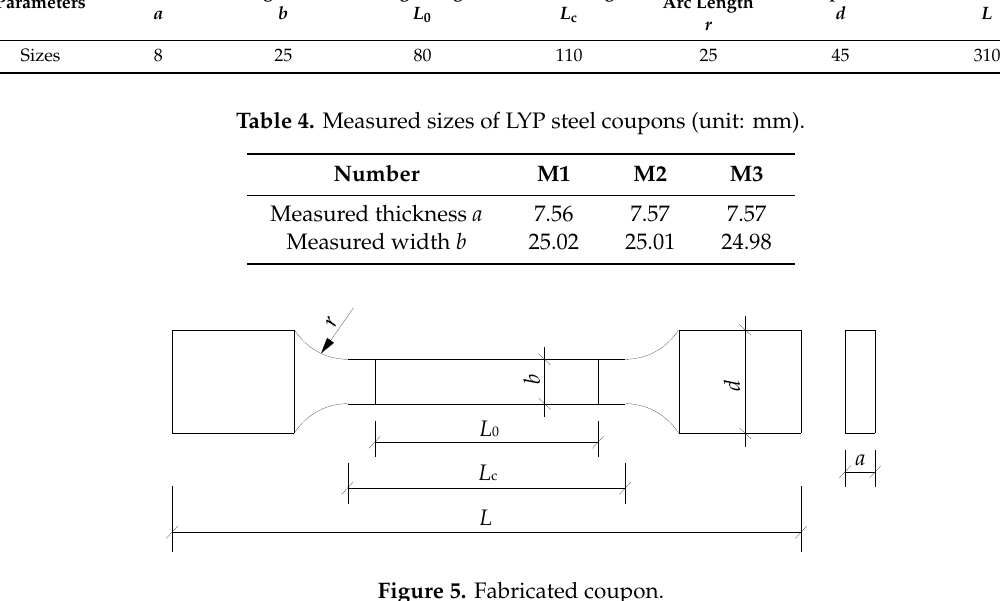
Figure 5. Fabricated coupon.